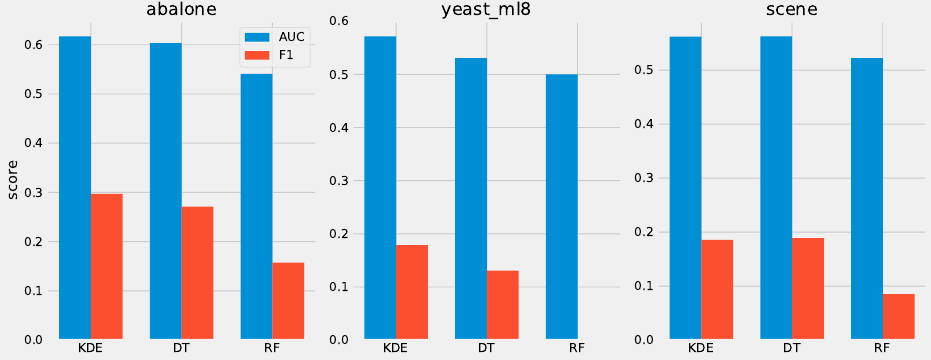
Figure 5. Classifier performances as measured by AUC and the F 1